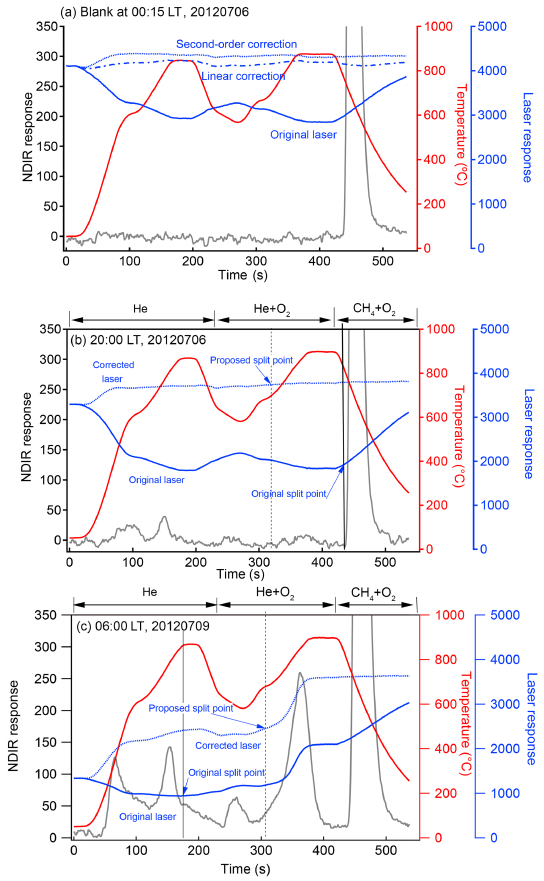
Figure A2. Thermograms of selected Riyadh samples: (a) blank at 00:15LT, 6 July 2012; (b) ambient sample at 20:00LT, 6 July 2012 with relatively low EC loading; (c) ambient sample at 06:00LT, 9 July 2012 with relatively high EC